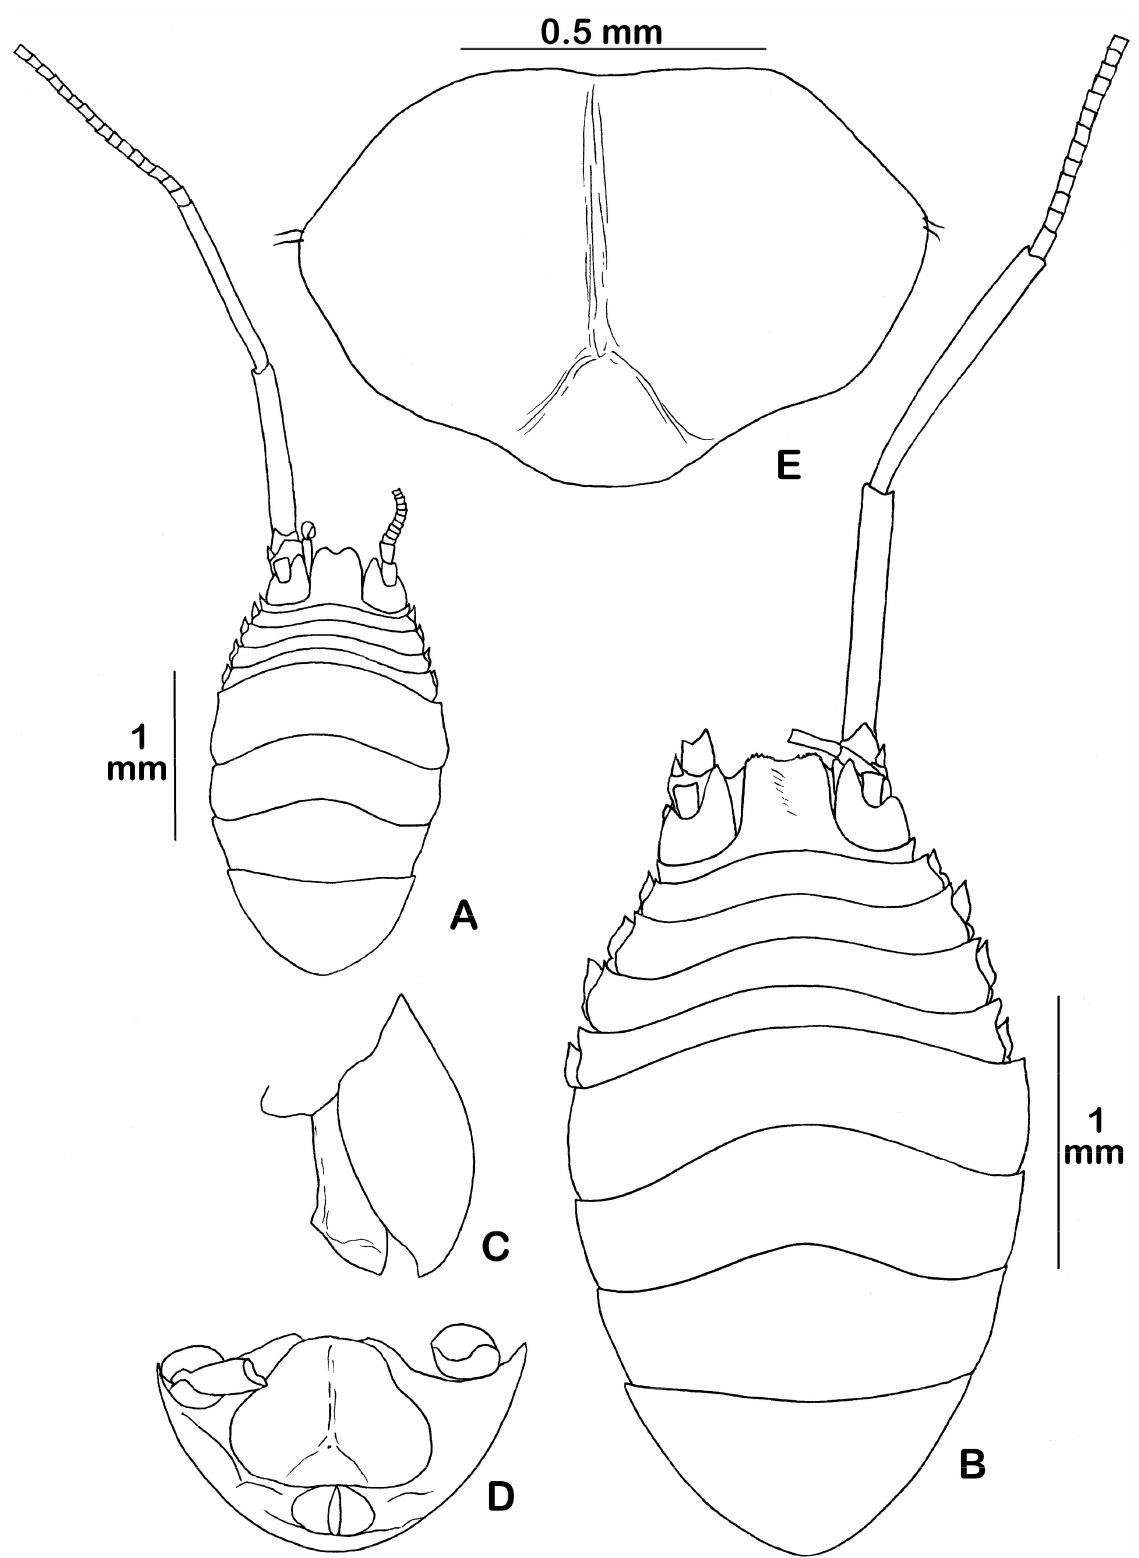
Figure 25. Eurycope gordeyi sp. nov. Male paratype (ZMH K-45646): ( A ) dorsal view; female paratype (ZMH K-45651): ( B ) dorsal view; ( C ) pleotelson lateral view; ( D ) pleotelson ventral view. Female paratype (ZMH K-45638): ( E ) pleopod